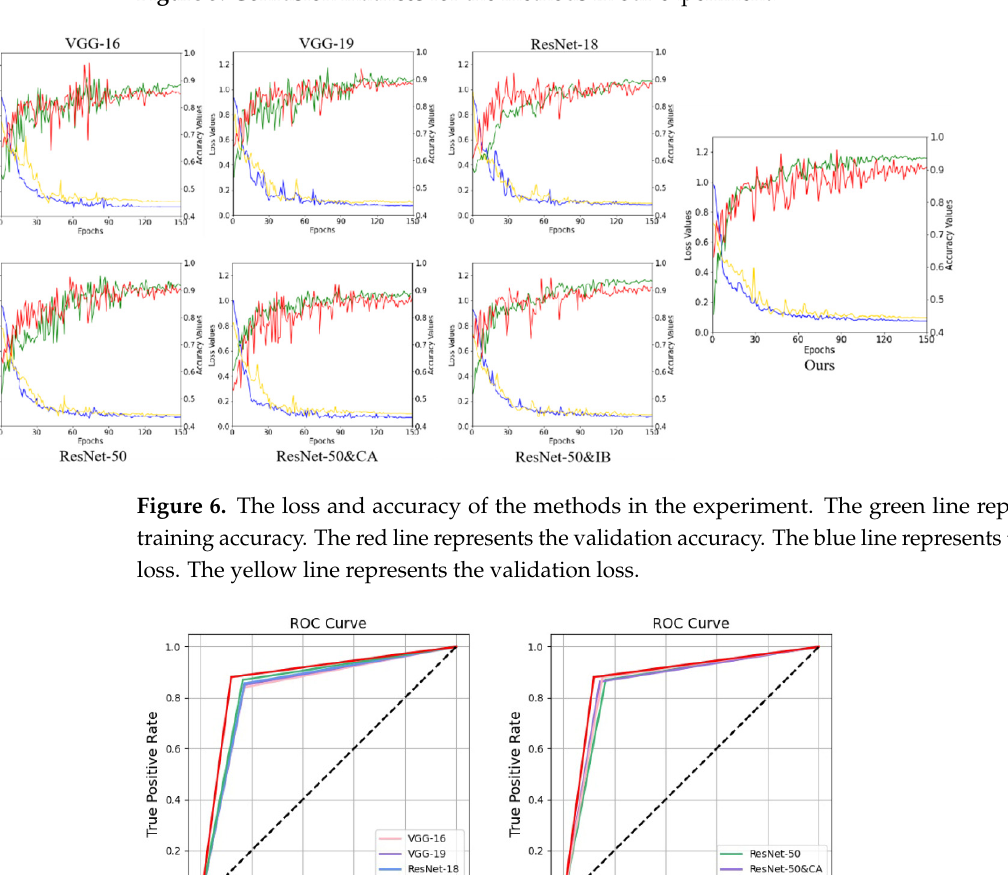
Figure 5. Confusion matrices for the methods in our experiment.